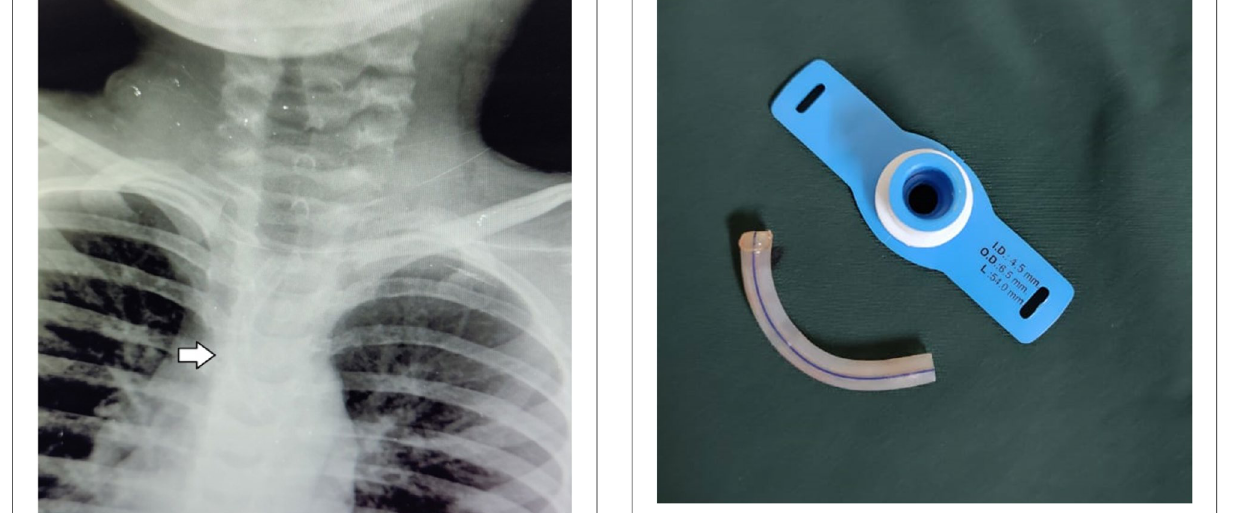
Fig. 2 Broken tracheostomy